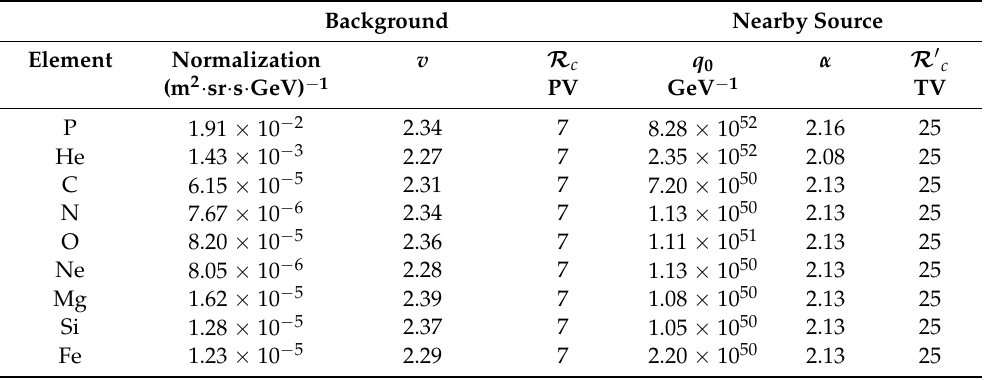
Table 2. Injection parameters of the background and the nearby source (The normalization is set at total energy E = 100